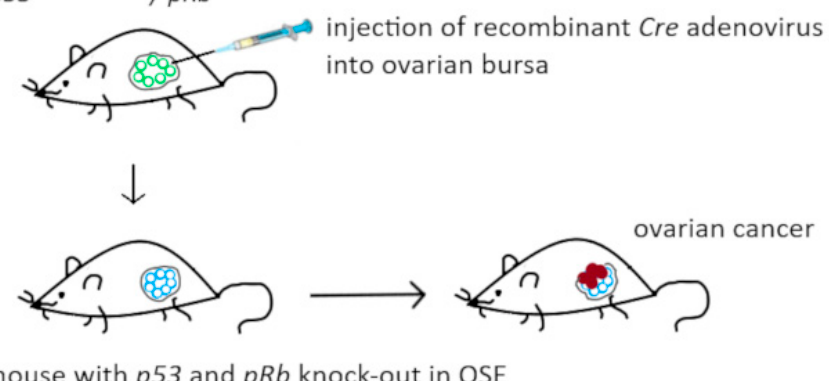
Figure 3. Mouse model used by Flesken-Nikitin et al. [71] for specific knock-out of p53 and pRb genes in OSE cells.